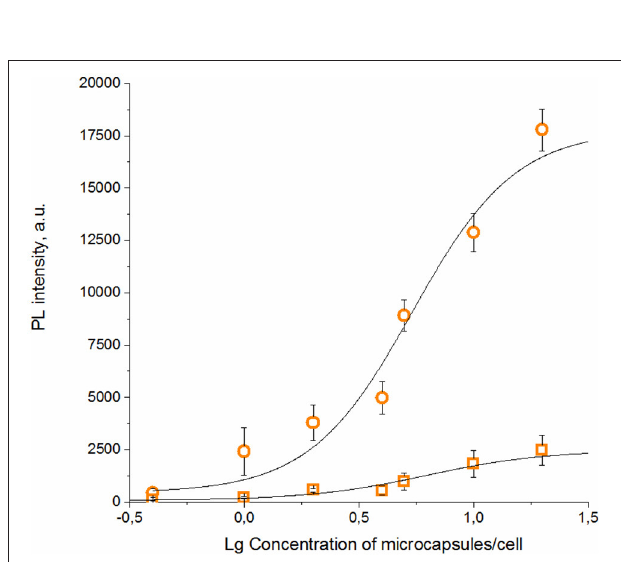
FIGURE 4 | Binding curves of the QD-encoded polyelectrolyte microcapsules conjugated with trastuzumab (circles) and QD-encoded microcapsules without protein coating as a control (squares) are